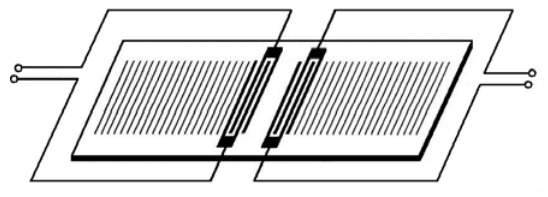
Figure 5. Scheme of a two-port SGAW